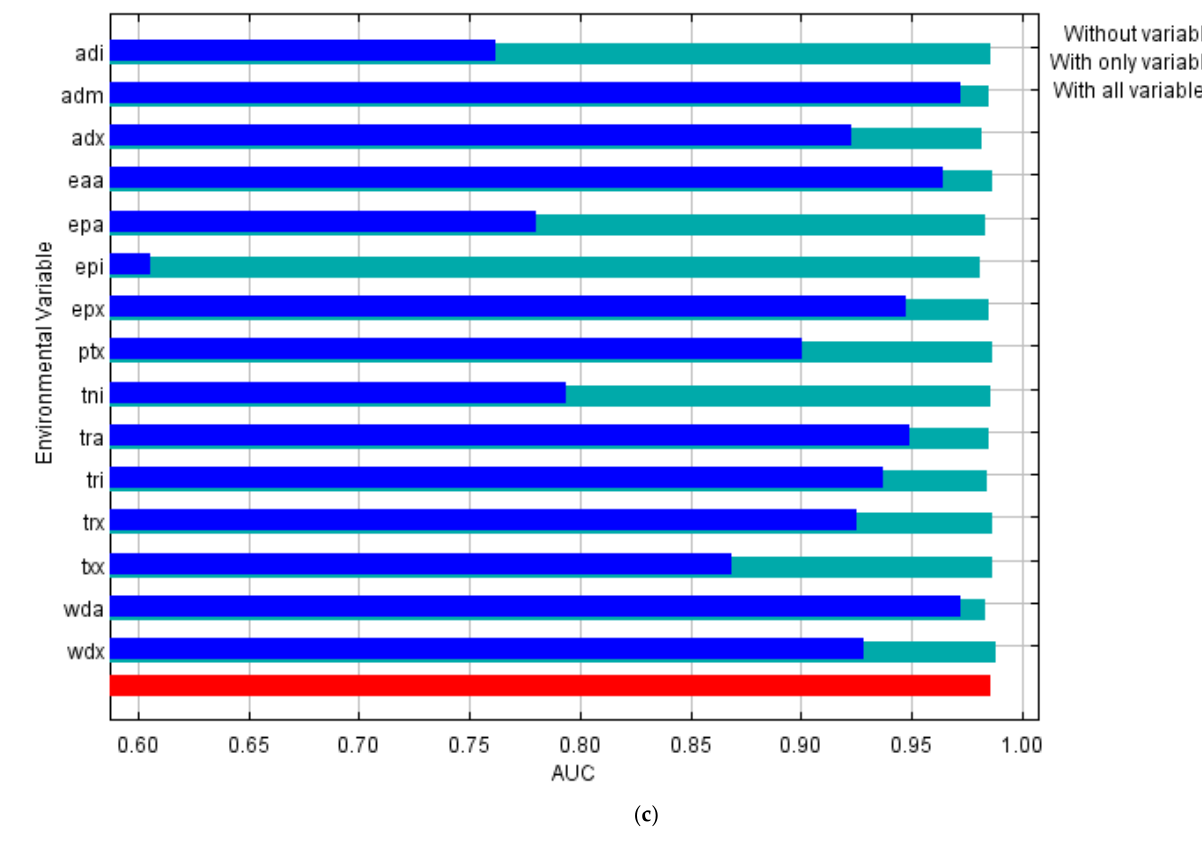
Figure 2. Jackknife analysis results for ( a ) Culex annulirostris, ( b ) Culex quinquefasciatus and ( c ) Culex sitiens where the blue line represents species distribution model gain when each climate layer is included on its own. Dark blue lines represent model performance when only the climate variable of interest was included, where the longer the dark blue bar, the higher the model gain which suggests the variable contains information critical to mapping that species’ distribution. The red bar represents maximum model performance, while the light green bar represents model performance when that climate variable was excluded. Acronyms for each climate layer are defined as follows: adi (minimum monthly aridity index), adm (mean annual aridity index), adx (maximum monthly aridity index), eaa (annual total actual evapotranspiration, terrain-scaled using MODIS), epa (annual potential evaporation), epi (minimum monthly potential evaporation), epx (maximum monthly potential evaporation), ptx (maximum monthly precipitation), tni (minimum temperature — monthly minimum), tra (annual temperature range), tri (minimum monthly mean diurnal temperature), trx (maximum monthly mean diurnal temperature), txx (maximum temperature — monthly maximum), wda (annual atmospheric water deficit) and wdx (maximum monthly atmospheric water deficit).